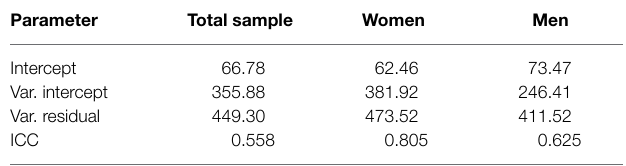
TABLE 6 | Results of the multilevel model investigating the effects of coping styles on situational coping for men.